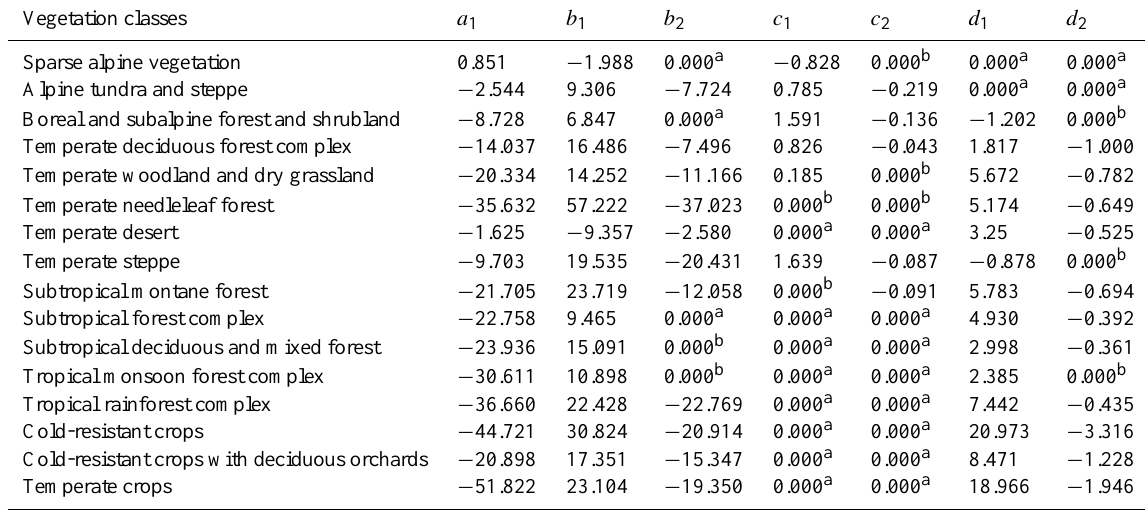
Table 2. Parameters used in Eq. (1) for each vegetation class. All parameters are statistically significant at p < 0 . 001 except b 1 and b 2 for subtropical montane forest significant at p < 0 . 05.